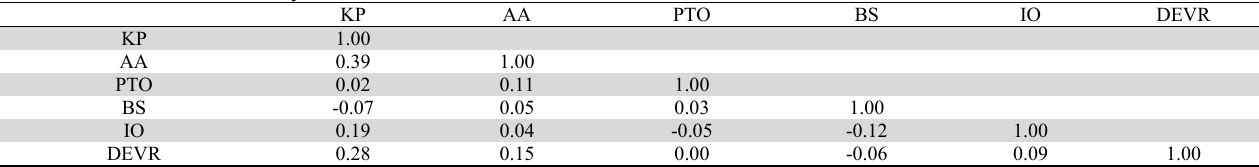
The Result of Multicollinearity Test